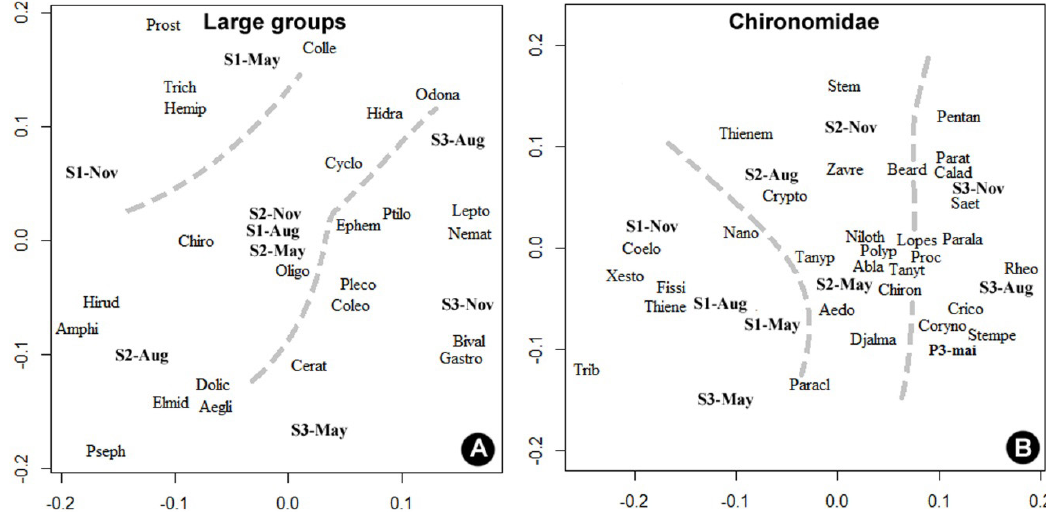
Figure 4. NMDS for spatial ordering of large groups of benthic macroinvertebrates (A) and also of chironomid genera (B). For captions of taxa see Table